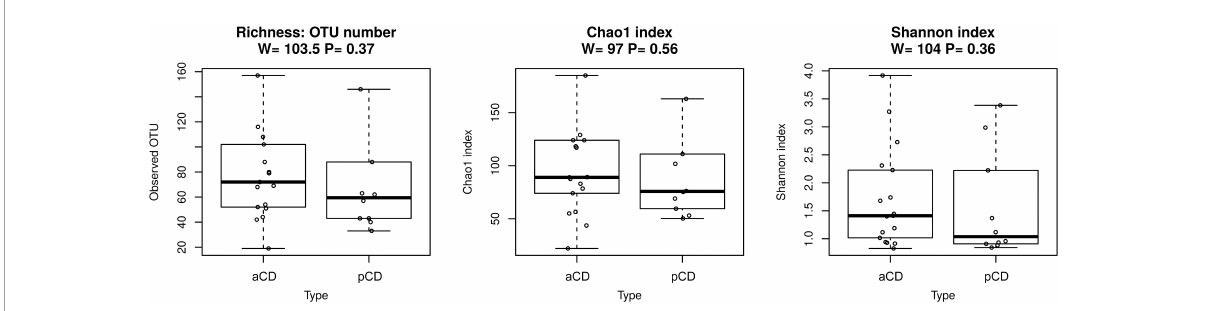
FIGURE2 Boxplots reporting alpha diversity indices (respectively, Richness, Shannon index, and Chao1 index) in aCD and pCD samples. Alpha diversity indexes are composite indexes reflecting abundance and consistency. Boxes represent the interquartile range (IQR) between the first and third quartiles (25th and 75th percentiles, respectively), and the horizontal line inside the box defines the median. Whiskers represent the lowest and highest values within 1.5 times the IQR from the first and third quartiles, respectively. P -values less than 0.05 were considered statistically